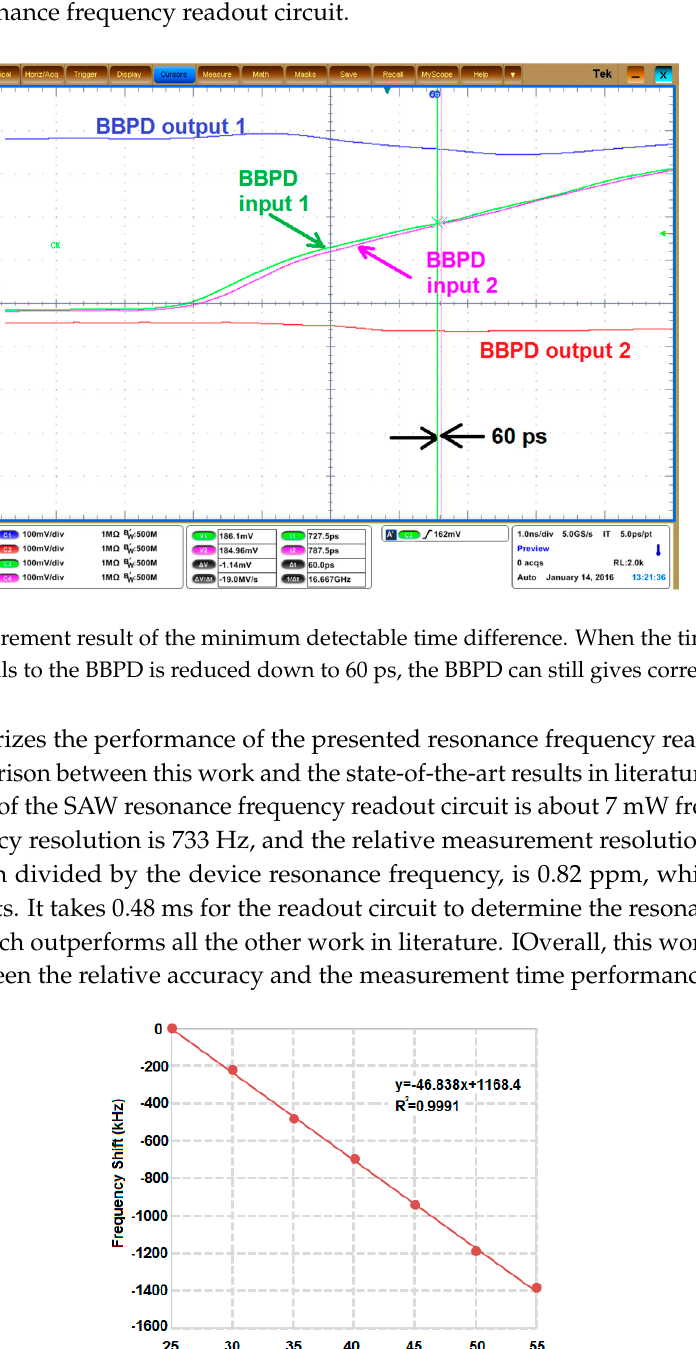
Figure 25. Measured SAW device resonance frequency shift against the environment temperature using the presented readout circuit.